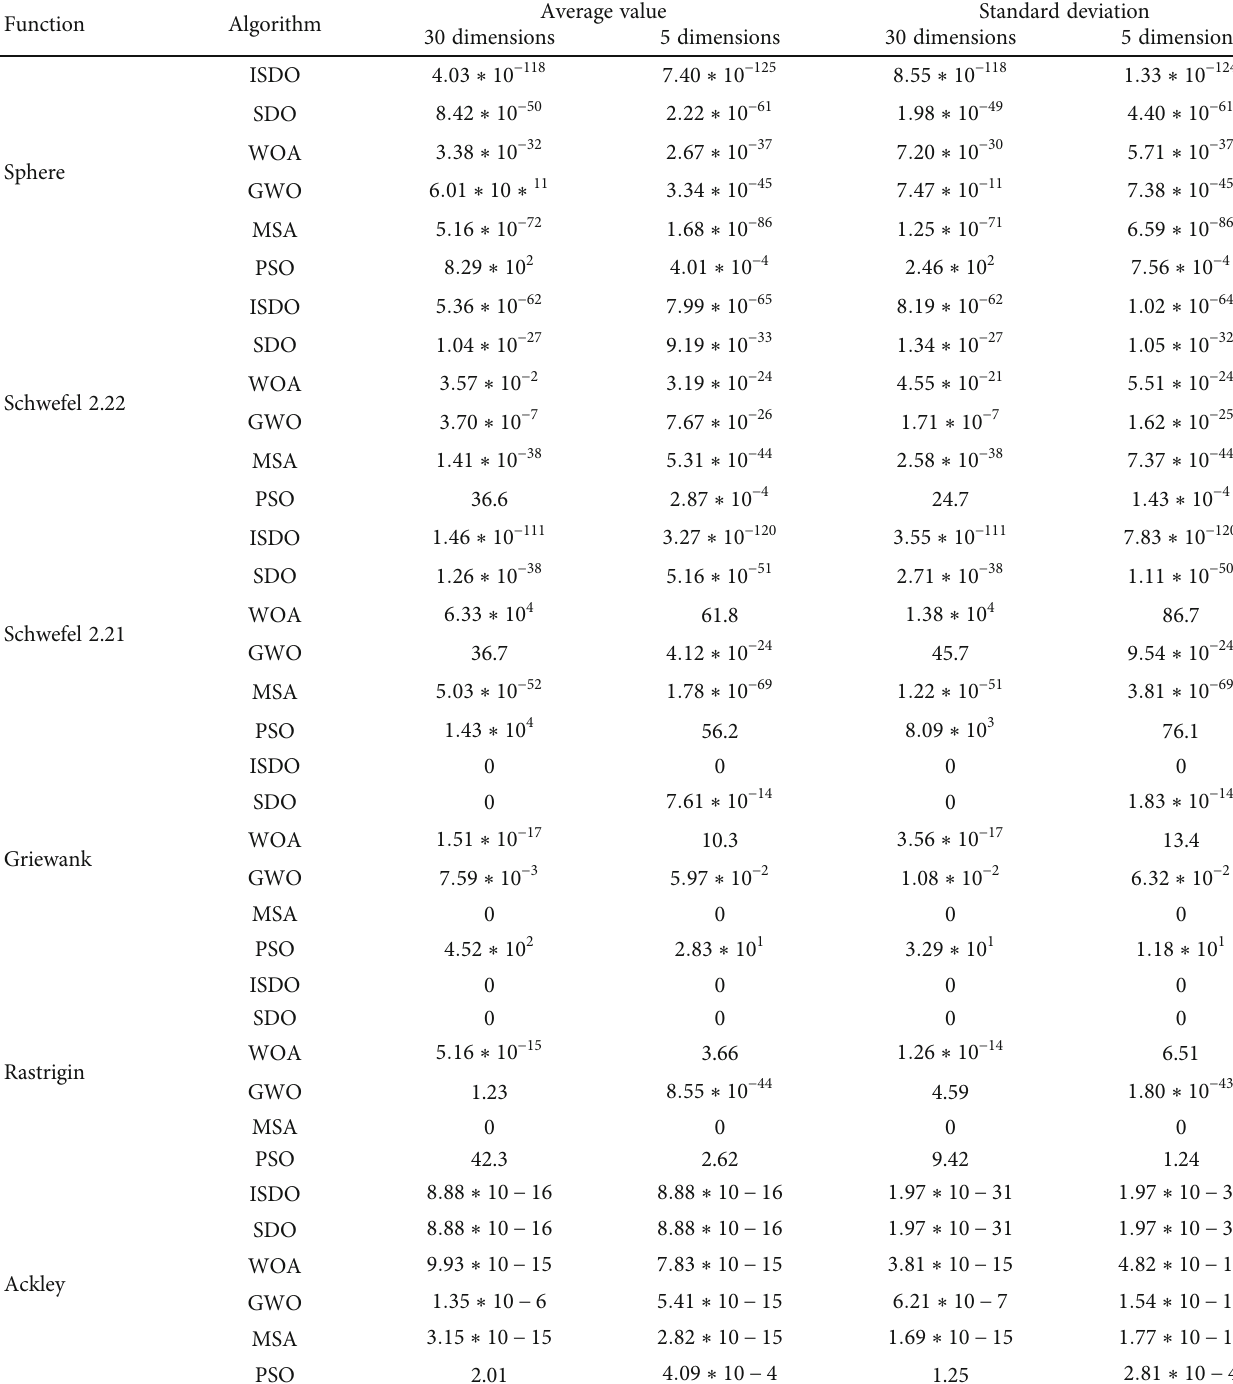
Table 1: Comparison results of function